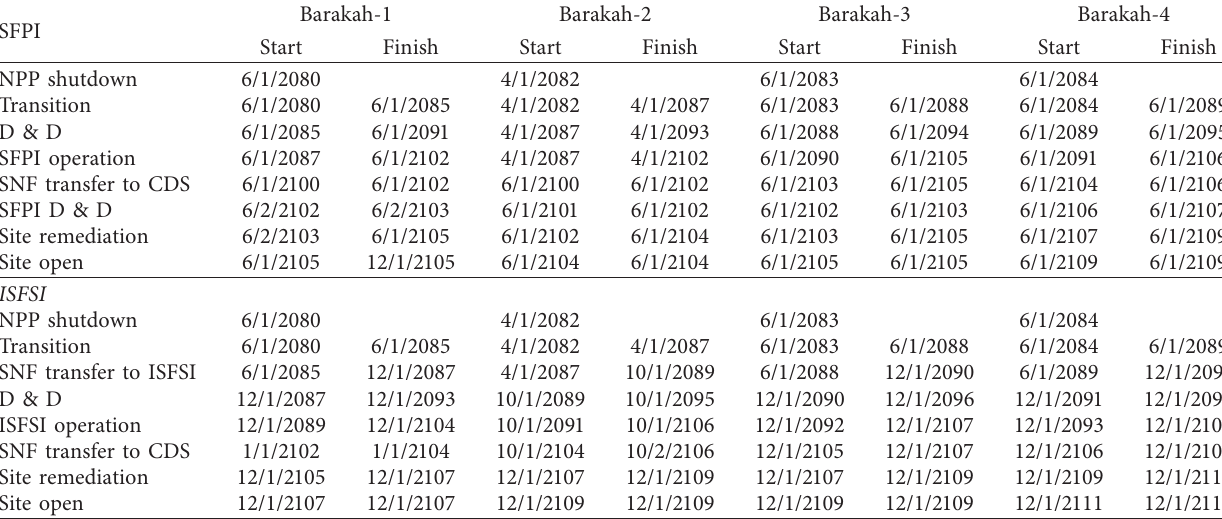
Table 5: Spent fuel transportation schedule for all Barakah sites.